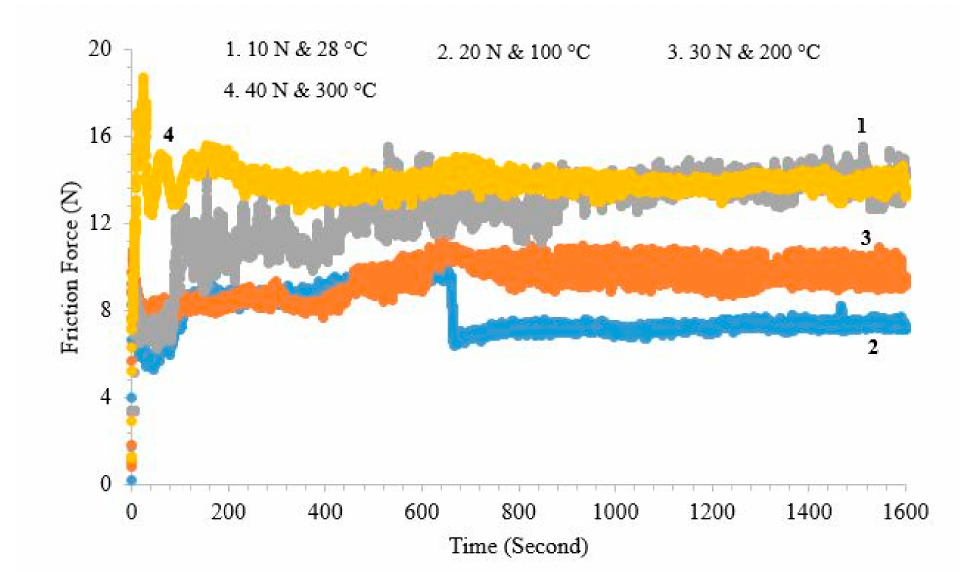
Figure 8. Friction force at a constant speed with increasing load and